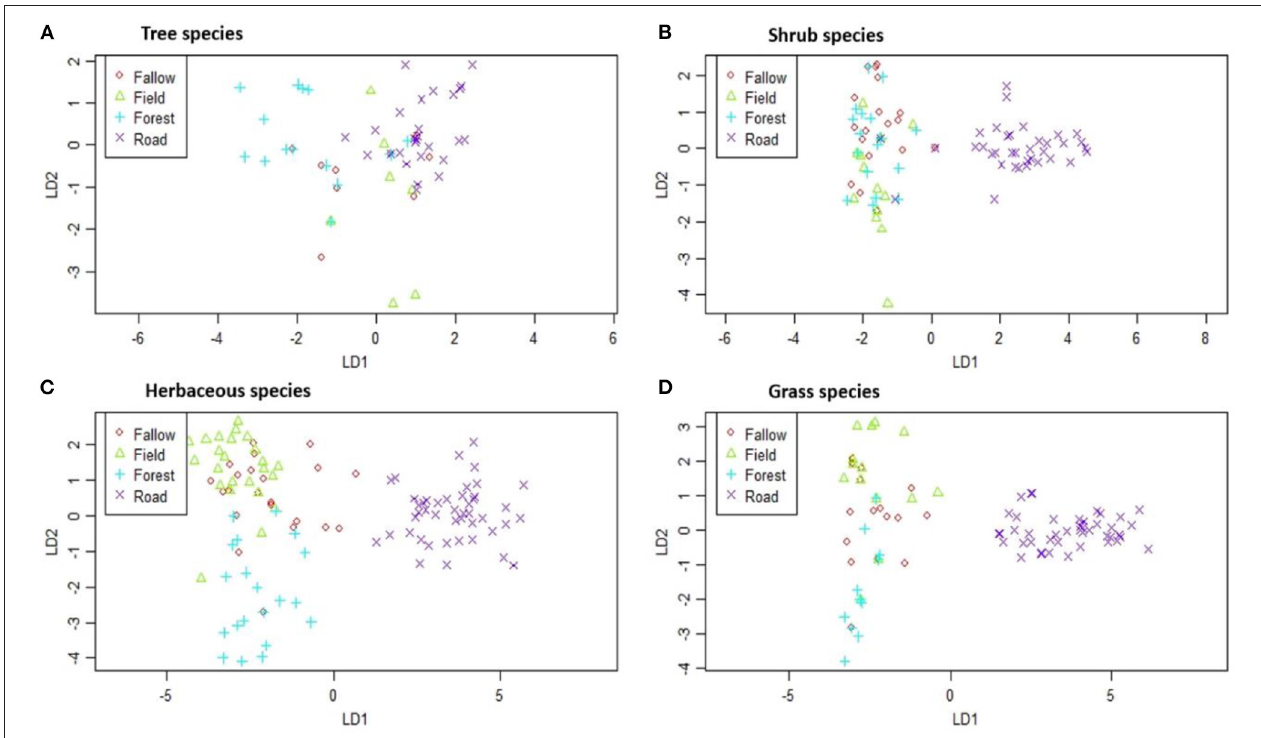
FIGURE 4 | Dissimilarity of (A) tree species, (B) shrub species, (C) herbaceous species, and (D) grass species among land-use types in Moribane Forest Reserve, central Mozambique. The symbols represent each plant life form species in each land-use type.